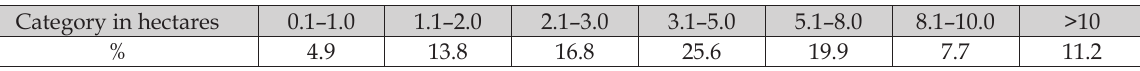
Table 3. Agricultural land by